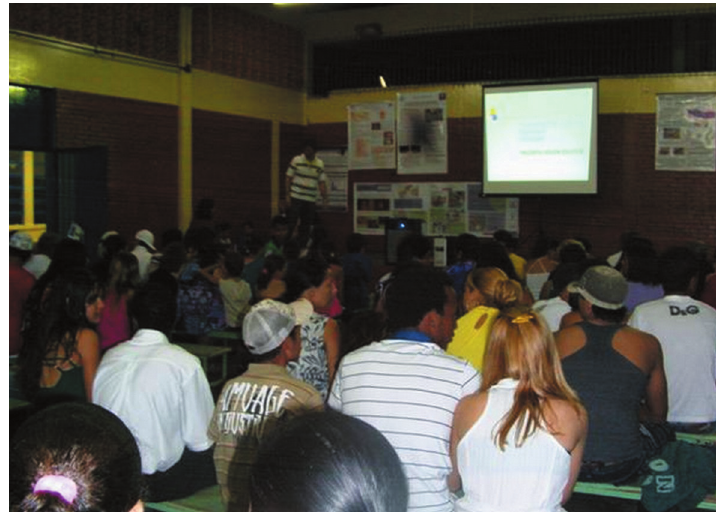
Figure 3- Production chain in health, knowledge and value hierarchy of the university to the